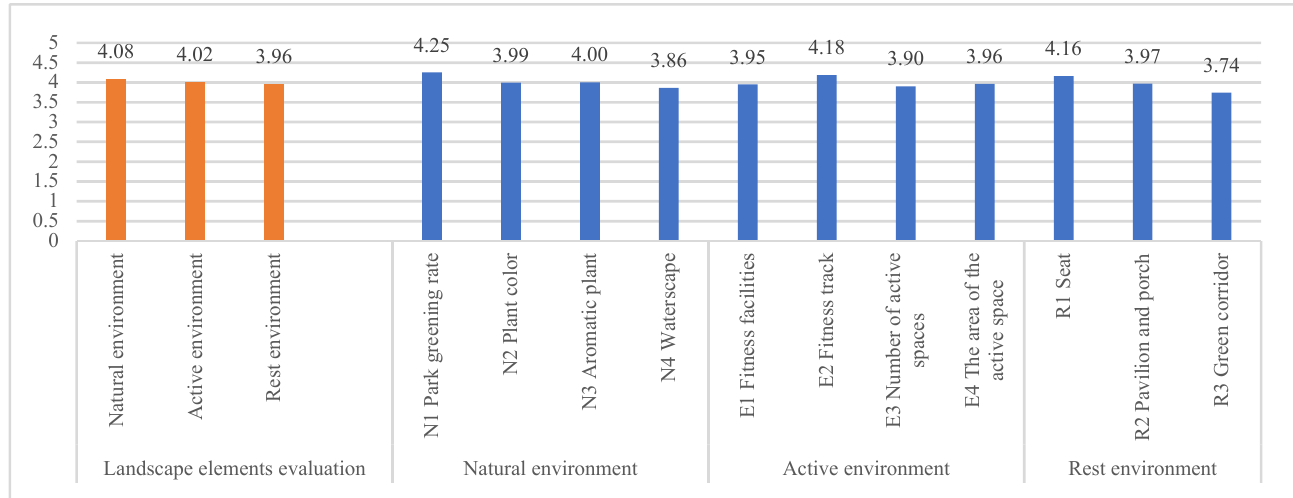
Figure 11. Evaluation statistics of landscape elements by community park users.